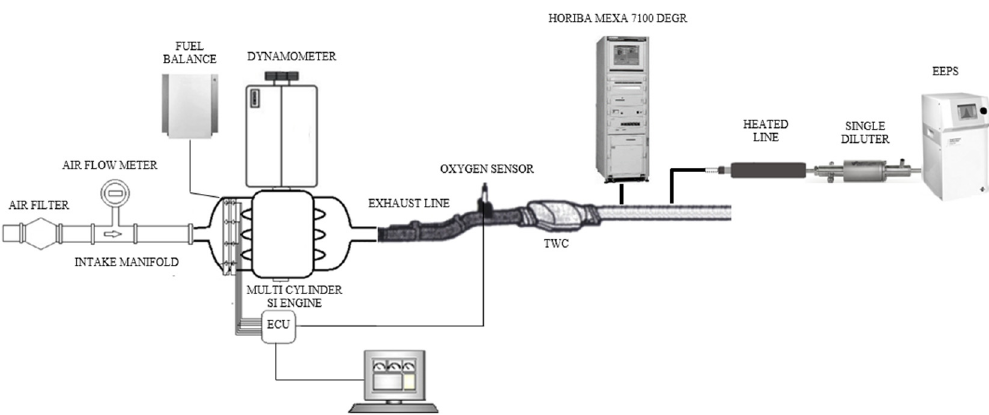
Figure 1. Schematic of the experimental